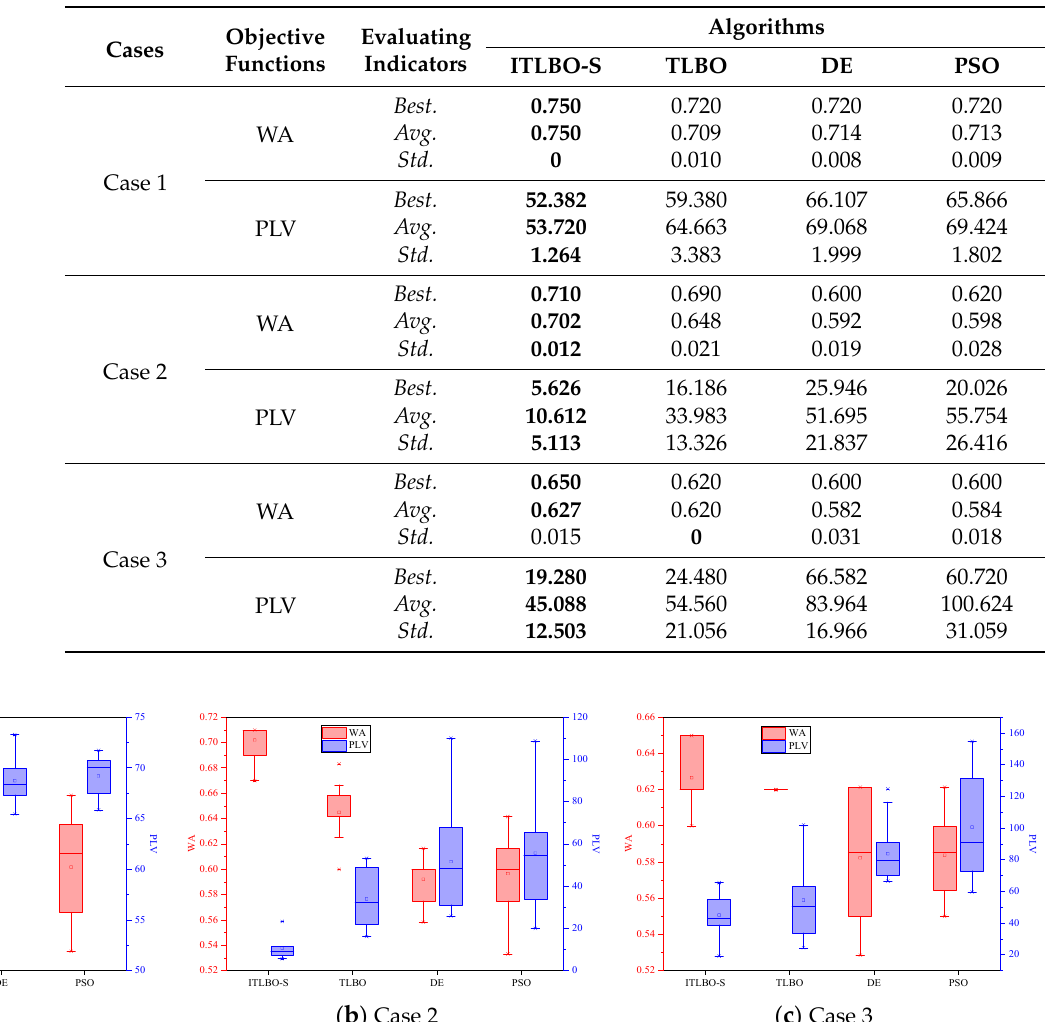
Table 5. Statistical comparison of algorithmic results.